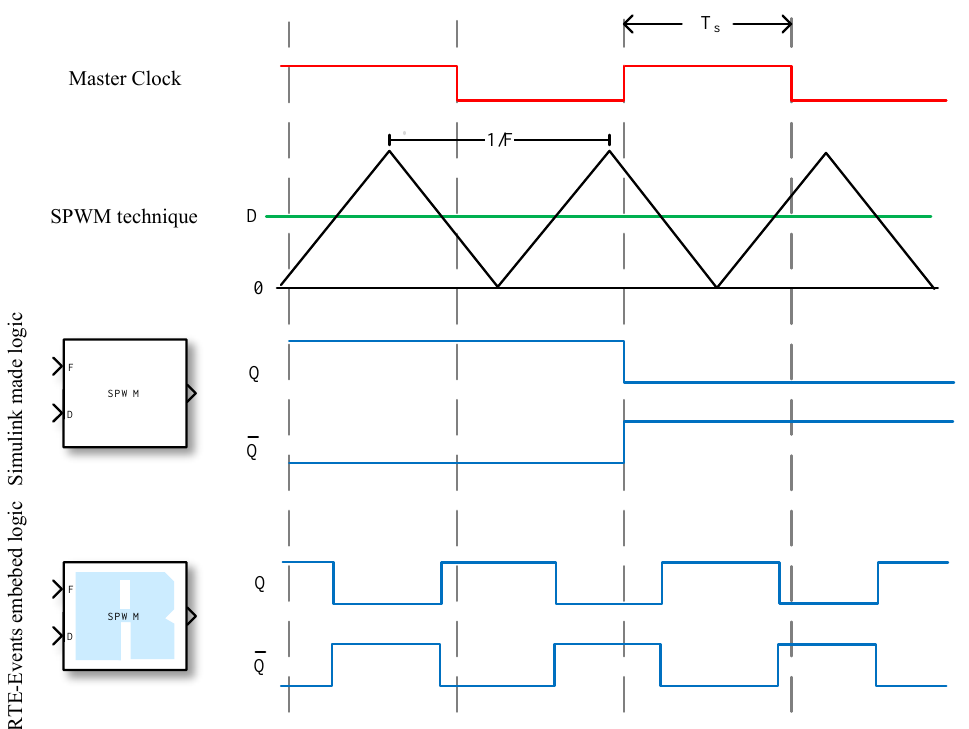
Figure 5. RTE-SPWM block and operation.